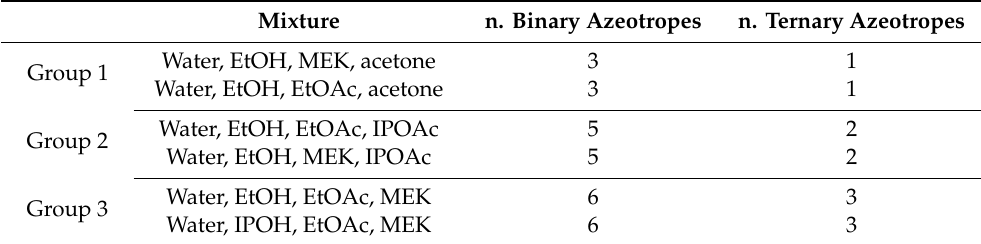
Table 1. Groups of nonideal mixtures with number of azeotropes formed. Mixture n. Binary Azeotropes n. Ternary